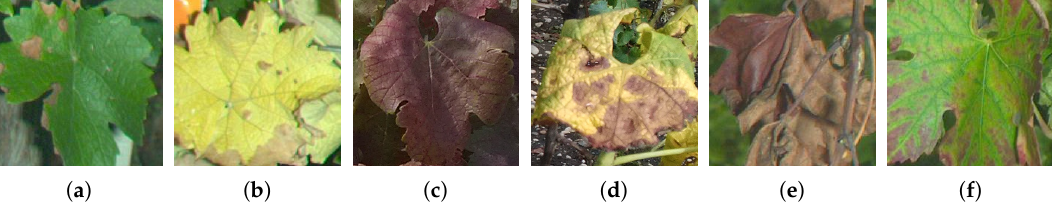
Figure 2. Examples of non-esca leaves showing foliar discolorations. ( a ) Black Rot, ( b ) Full yellowing, ( c , d ) Flavescence Dorée, ( e ) Wilted leaf, ( f )